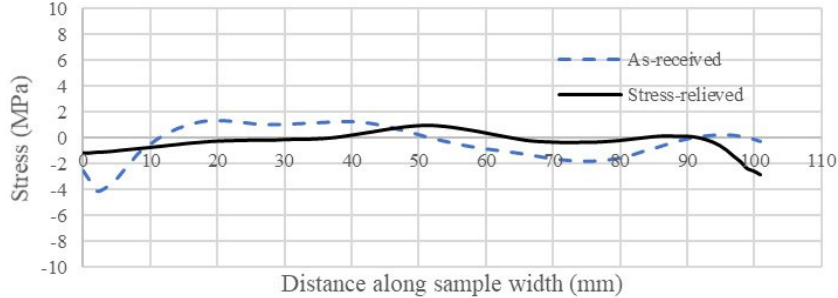
Figure 4. Residual stress profile (through-thickness averaged) of a wrought Ti-6Al-4V plate in as-received and stress-relieved conditions.